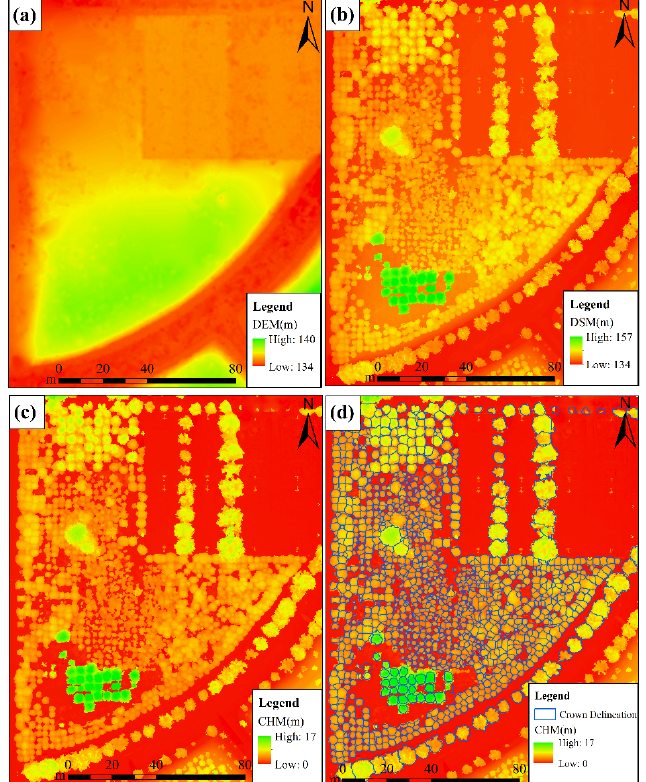
Figure 5. The DSM, DEM, CHM, and ITCD results: ( a ) DEM derived from UAV-RGB data; ( b ) DSM derived from UAV-RGB data; ( c ) CHM derived from UAV-RGB data; ( d ) ITCD results based on the watershed algorithm.